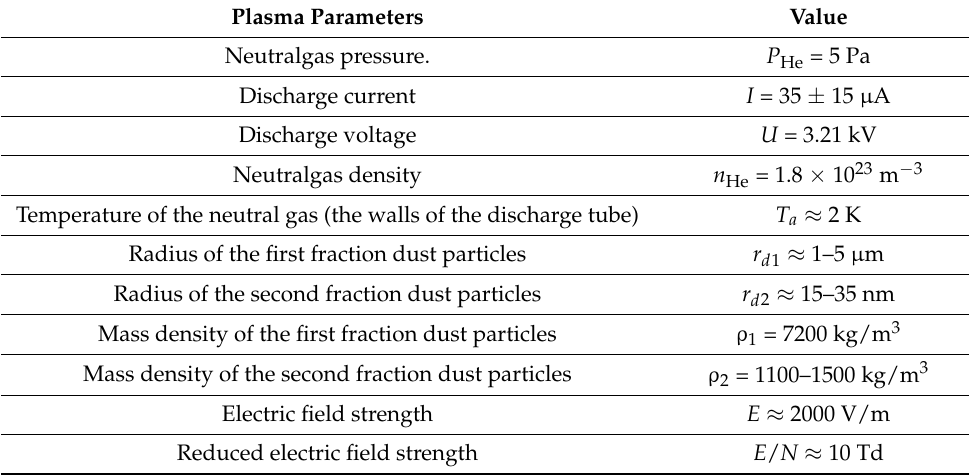
Table 1. The main parameters of the plasma.